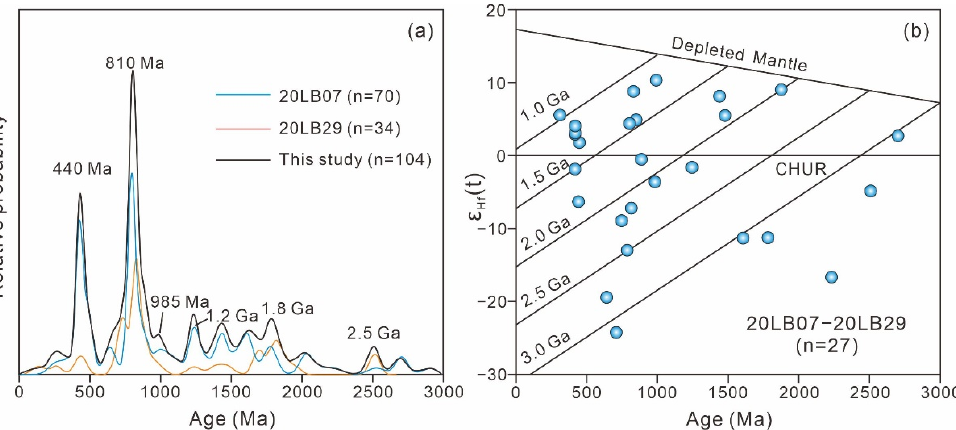
Figure 7. ( a ) Detrital zircon U–Pb age spectra of sample 20LB07 and 20LB29 from the Liba Group. ( b ) Detrital zircon ε Hf (t) values versus U–Pb age diagram of the Liba Group.